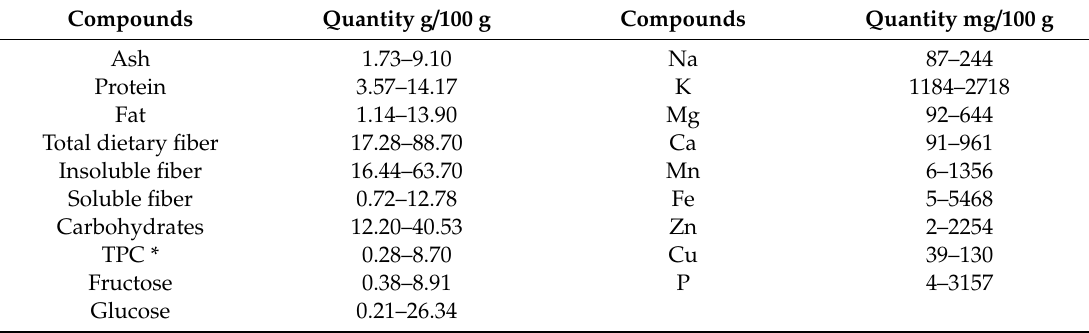
Table 1. Proximate composition of grape pomace based on dry weight (data from Bender et al. [9]; Mohamed Ahmed et al. [18]; Cilli et al. [19]; Beres et al. [12]; Theagarajan et al. [20]; Šporin et al. [21]; Tsengetal. [22]; Mildner-Szkudlarzetal. [23]; AcunandGul[11]; Nagarajaiahetal. [24]; Deng et al.